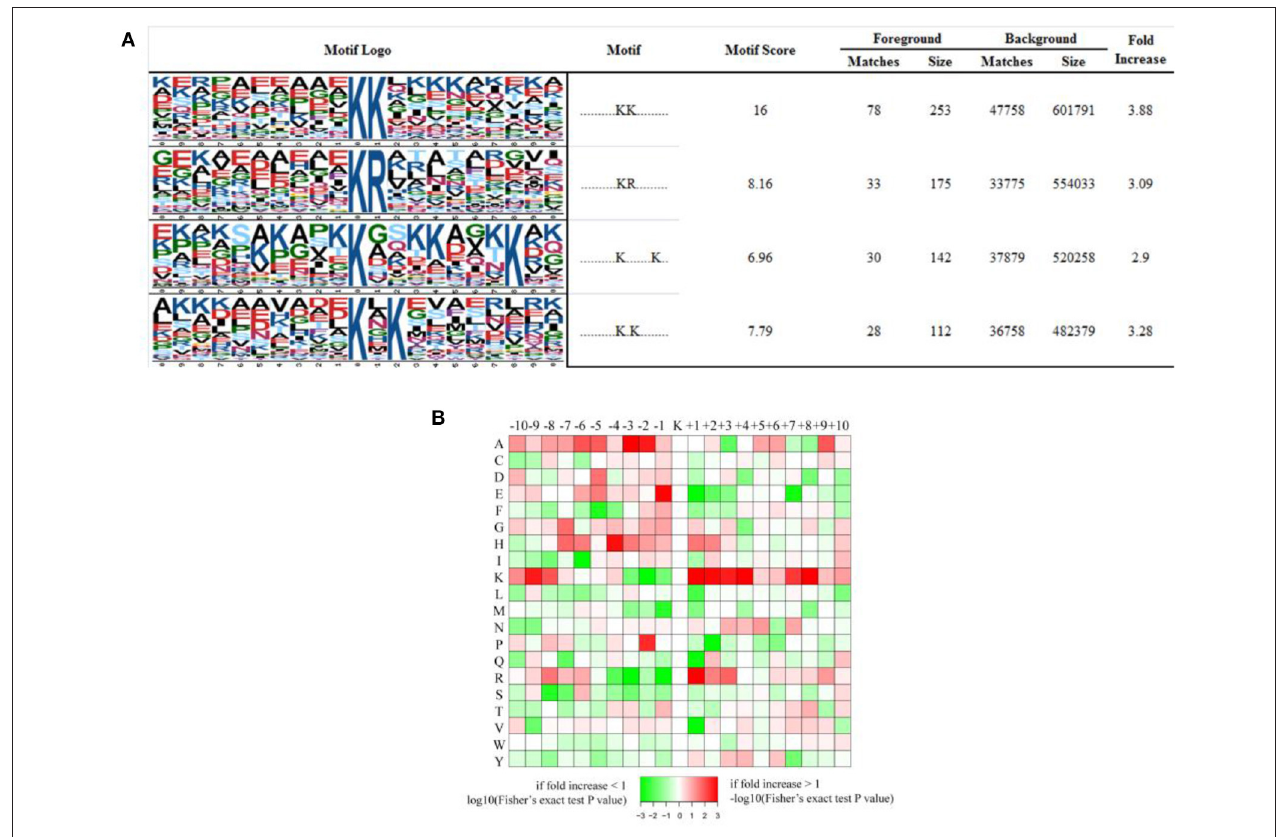
FIGURE 6 | Properties of all the identified Kac peptides. (A) Acetylation motifs, motif score, fold increase; (B) Heat map of the amino acid compositions of the acetylated sites showing the frequency of the different types of amino acids around the acetylated